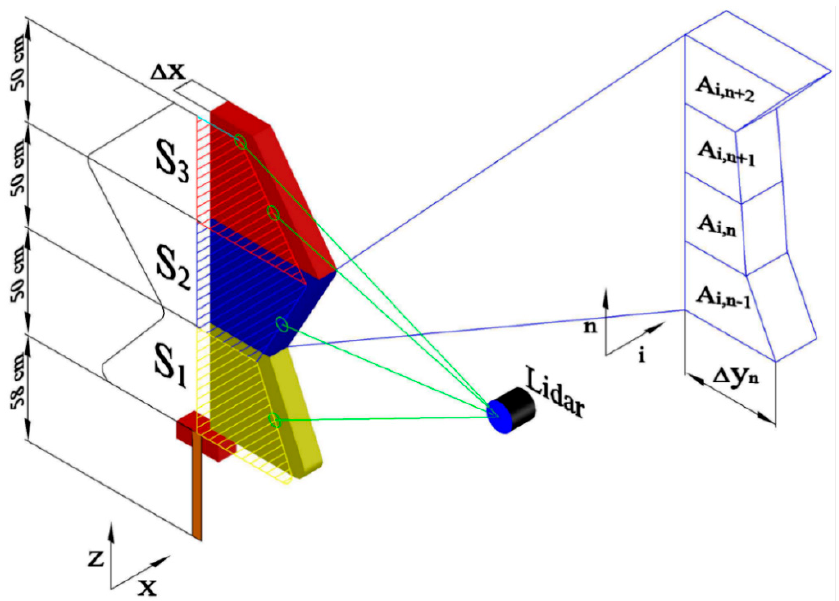
Figure 5. Representation of the calculation of vine canopy volumes of individual scans. A section of segments S13, S14, and S15 colored with yellow, blue, and red is on the left and representation of the volume calculation from multiple points within segment S14 using the trapezoidal method is on the right.